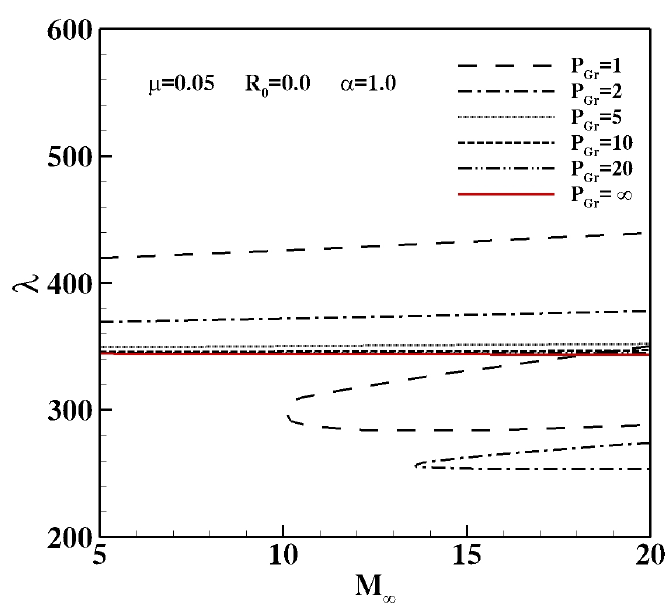
Figure 19. Variation curve of critical dynamic pressure with freestream Mach number for different pressure drop